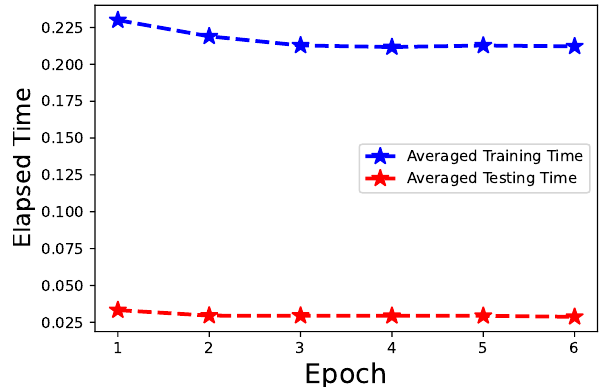
Figure 10. Training and testing time.